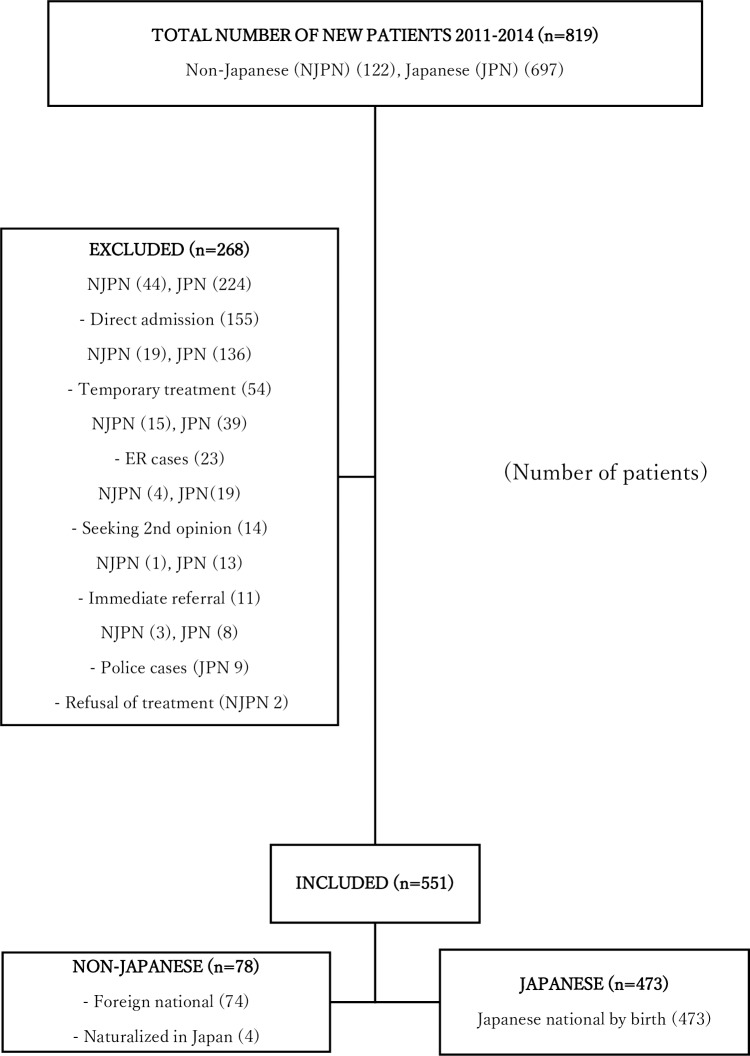
Flow diagram of patient selection.